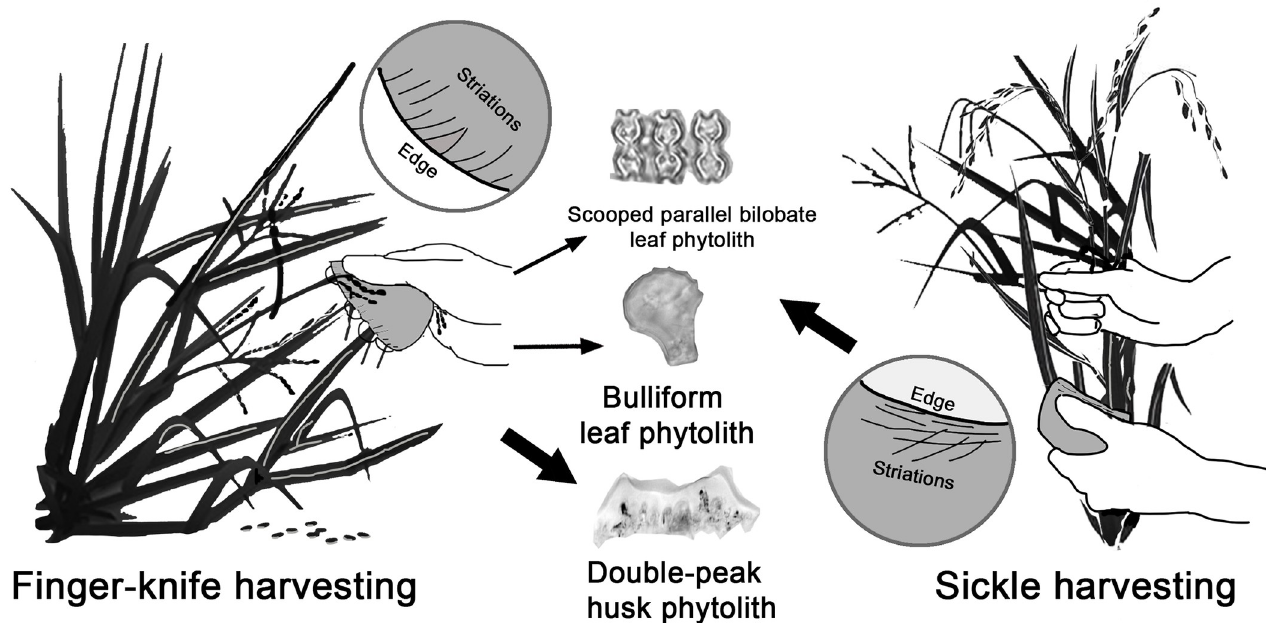
Fig 7. Schematic representation of the use-wear traces and phytoliths from rice-harvesting finger knives and